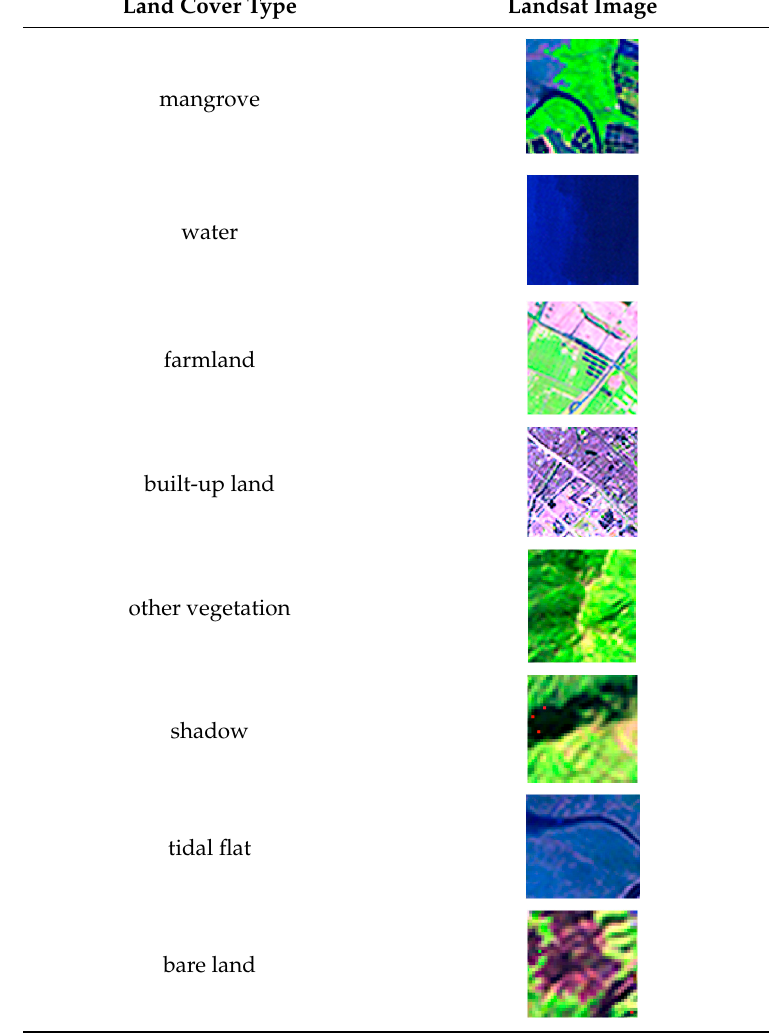
Table 2. Number of polygon samples selected for training classification rules.